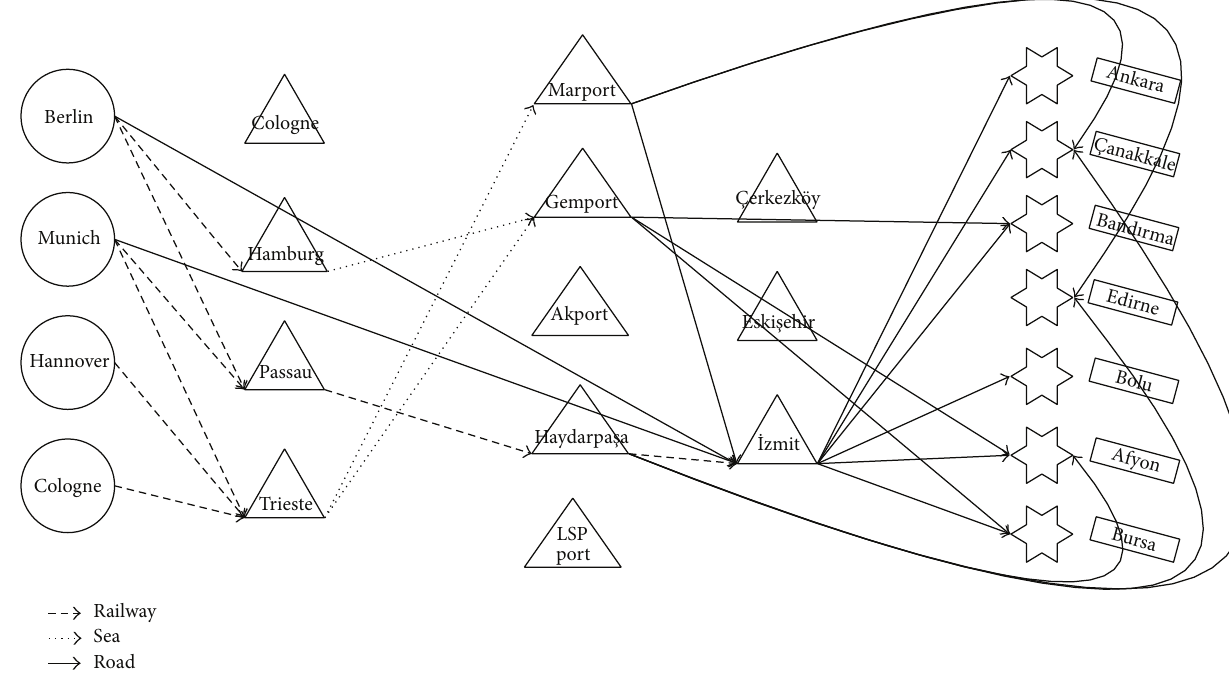
Figure 6: The obtained transportation network.